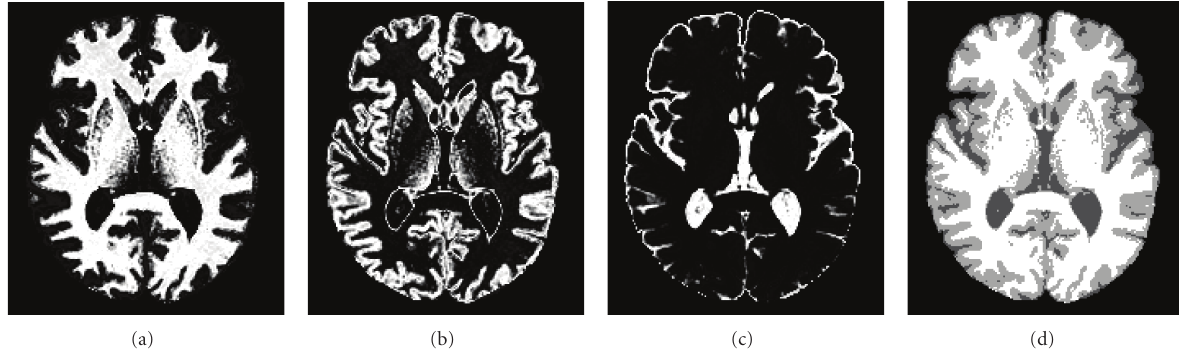
Figure 5: Fuzzy segmentation of an image into three membership functions. (a) the white matter (WM), (b) cgray matter (GM), (c) cerebrospinal fluid (CSF), and (d) Corresponding hard segmentation.